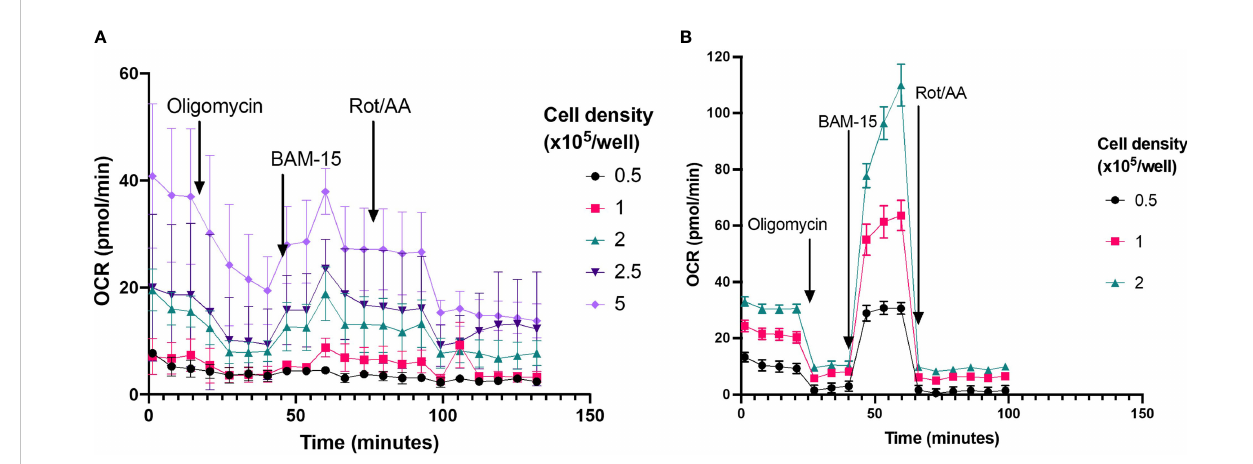
FIGURE 7 Probing OCR from neutrophils and PBMCs seeded at different cell densities. (A) Mitochondrial respiratory activity of isolated neutrophils seeded between 0.5-5 x 10 5 cells/well were probed by sequential injection of 2 µM oligomycin (injection 1), 3 µM BAM-15 (injection 2) and 2 µM rotenone/ antimycin A (Rot/AA) (injection 3), to establish rates of adenosine triphosphate (ATP)-coupled, maximal mitochondrial respiratory activity and non- mitochondrial oxygen consumption, respectively. Cell purity was assessed using H&E staining, mean neutrophil purity was 97% the contaminating cells were 2% monocytes and 1% lymphocytes. Data are means ± standard error of the mean (SEM) from 4 distinct donors (B) Mitochondrial respiration of isolated PBMCs seeded between 0.5-2x10 5 cells/well were probed by sequential injection of 2 µM oligomycin (injection 1), 3 µM BAM- 15 (injection 2) and 2 µM rotenone/antimycin A (Rot/AA) (injection 3), to establish rates of adenosine triphosphate (ATP)-coupled, maximal mitochondrial respiratory activity and non-mitochondrial oxygen consumption, respectively. Data are means ± standard error of the mean (SEM) 4 technical replicates.